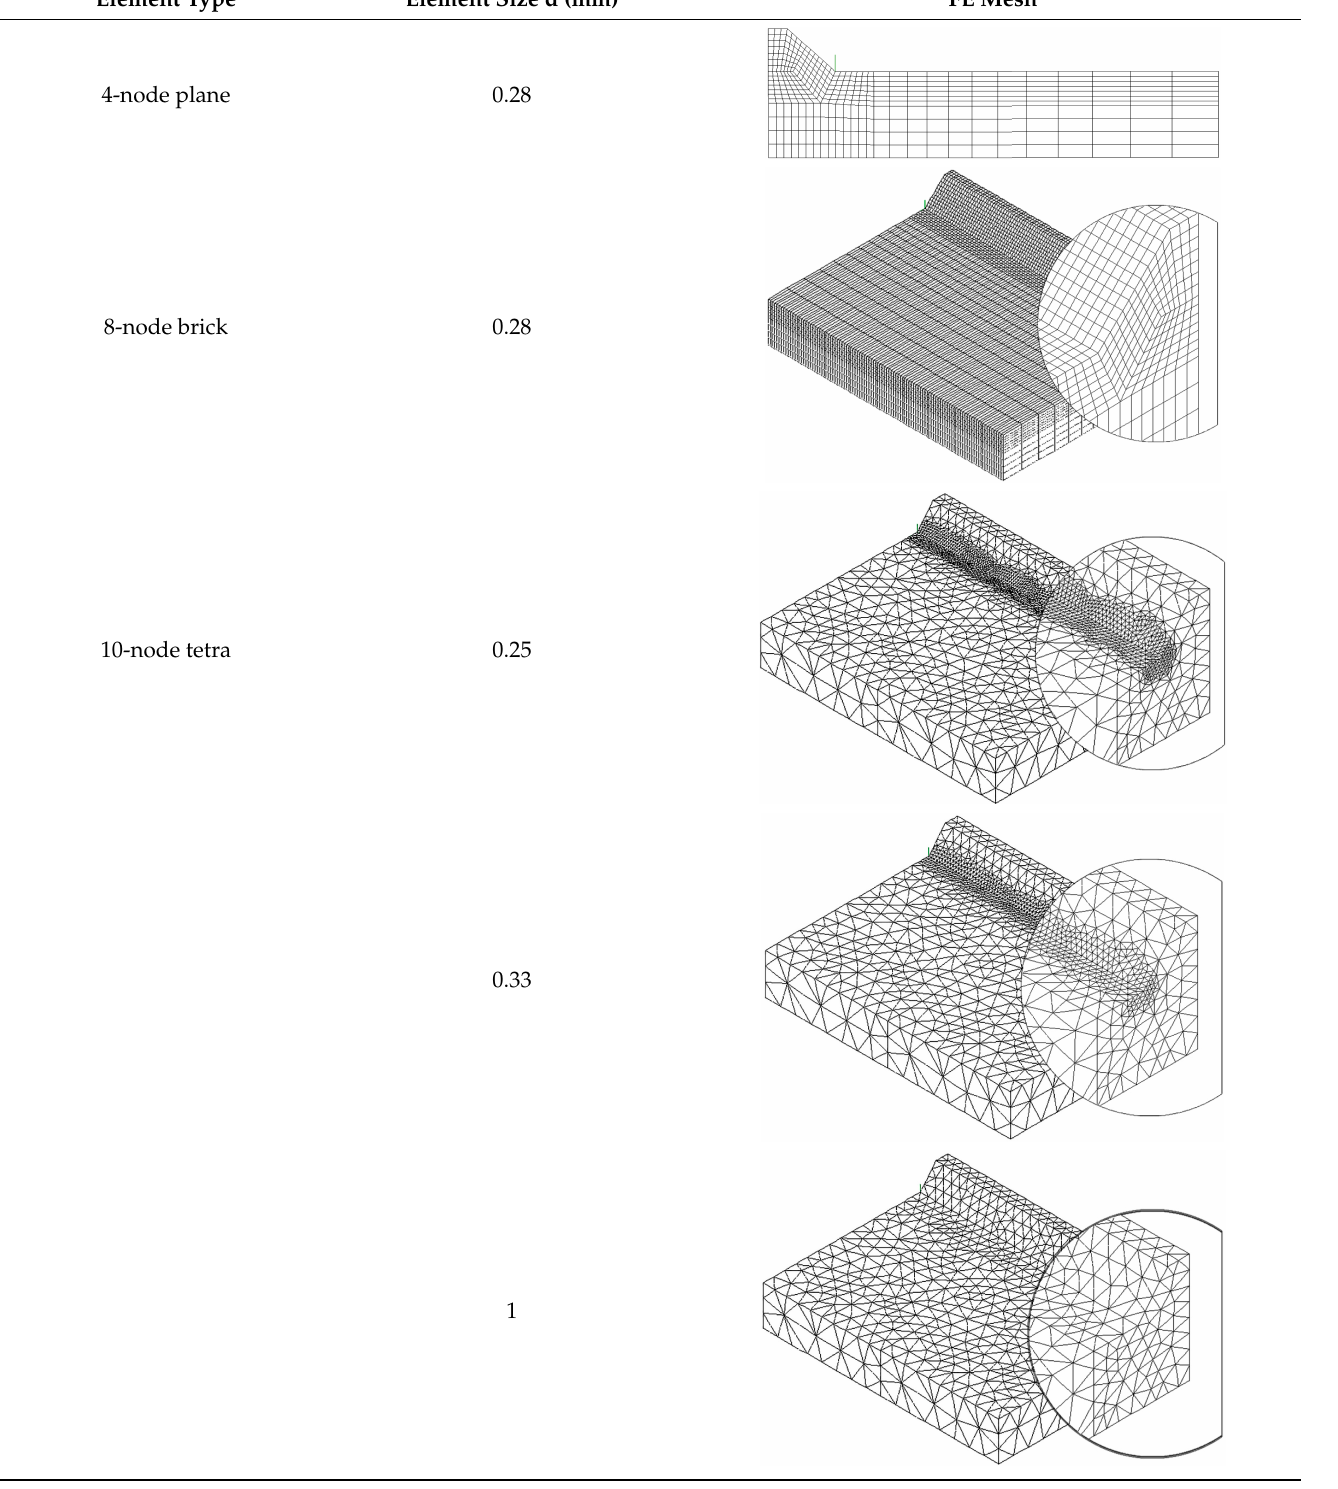
Table 3. Comparison of FE mesh patterns adopted to estimate the R-NSIF K I according to the Peak Stress Method (PSM). Element